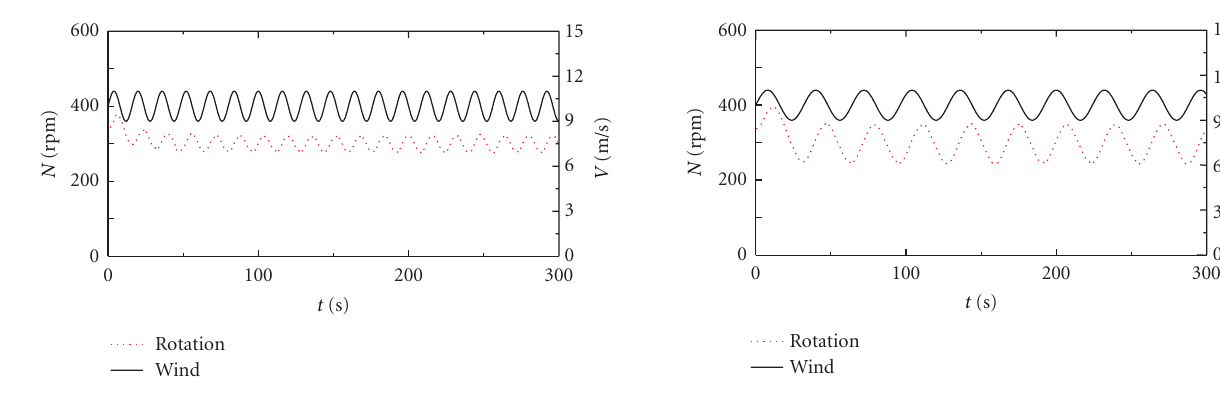
Figure 24: Time profile of rotational speed of pulsating wind in the case where V 0 = 10m/s, T = 32s, and I = 5kgm 2 .